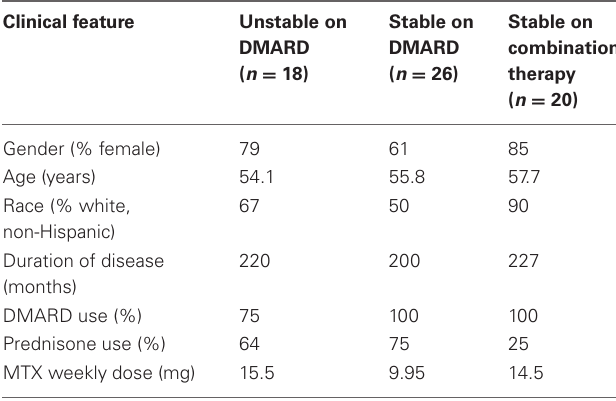
Table 1 | Clinical features of RA patient subpopulation groups tested for qRT-PCR